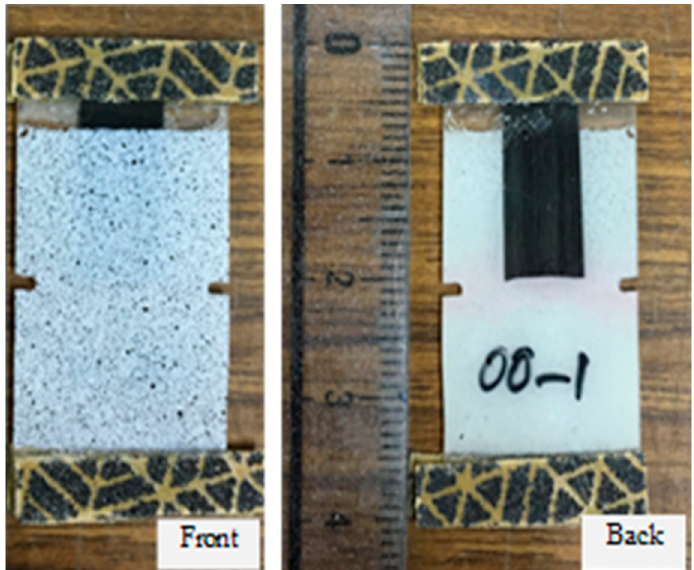
Figure 2. Image of model specimen with the speckle pattern from black and white paint for measuring strain distribution.